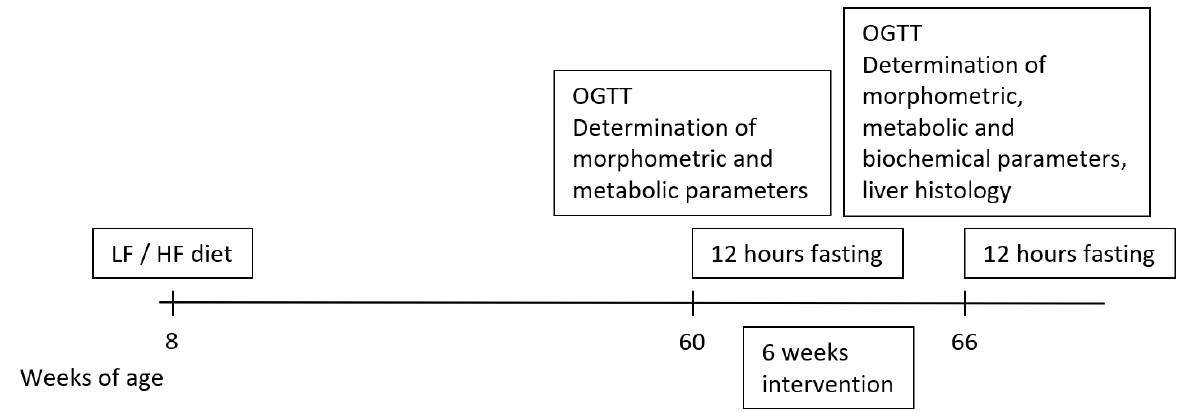
Figure 1. Design of experiment of WKY rats fed HF